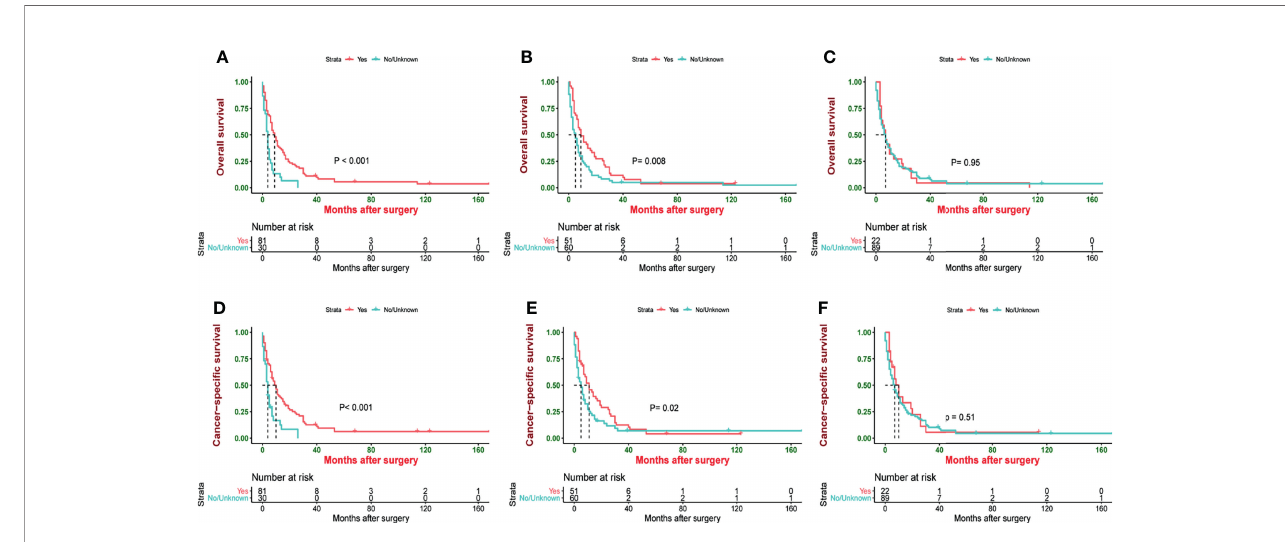
FIGURE 1 | Kaplan – Meier estimate of overall survival (OS) and cancer-speci fi c survival (CSS) stage IV patients by (A) surgery, (B) chemotherapy, (C) radiotherapy, (D) surgery, (E) chemotherapy, and (F)